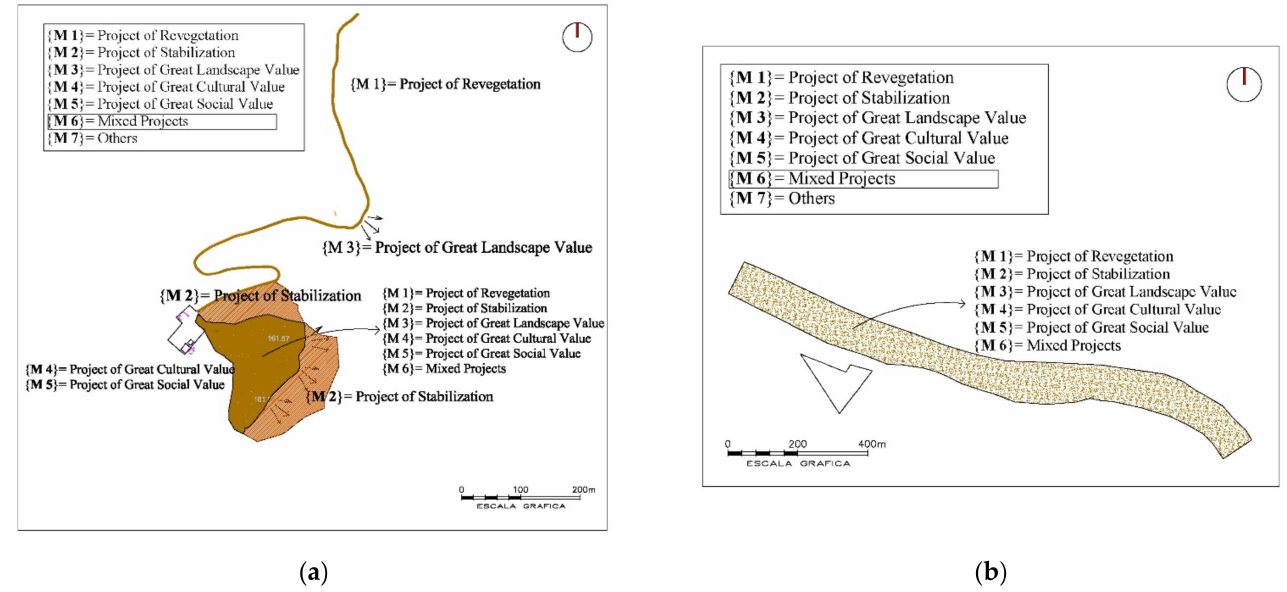
Figure 3. Model of action selected and location in map for: ( a ) Case Study 1, and ( b ) Case Study